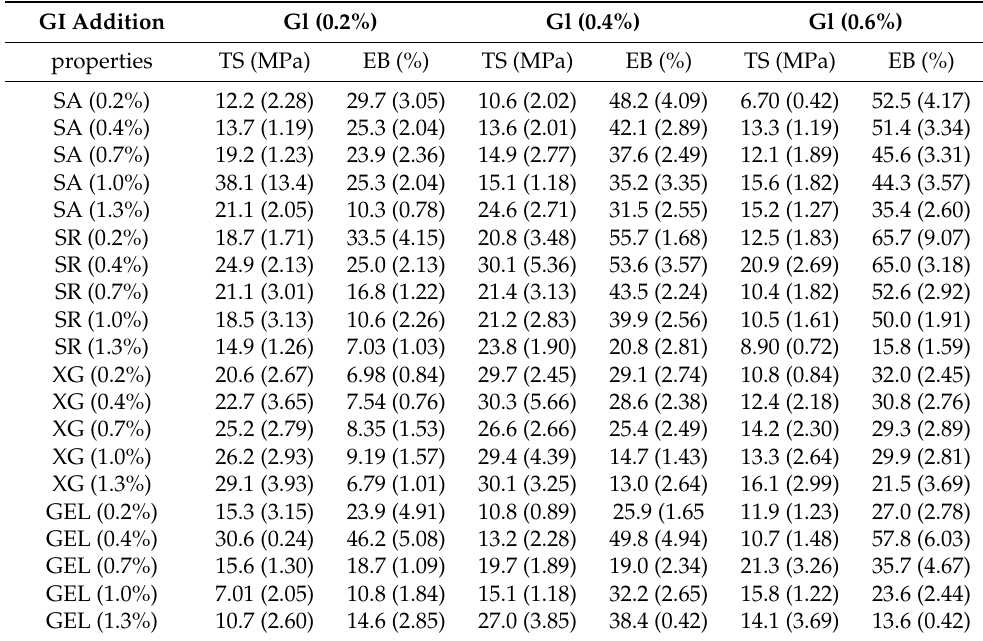
Table 1. The effect of GI addition on tensile strength (TS) and elongation at break (EB) of the composite films.